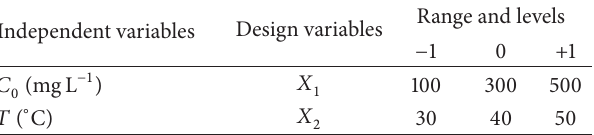
Table 5: Experimental range and levels of independent process